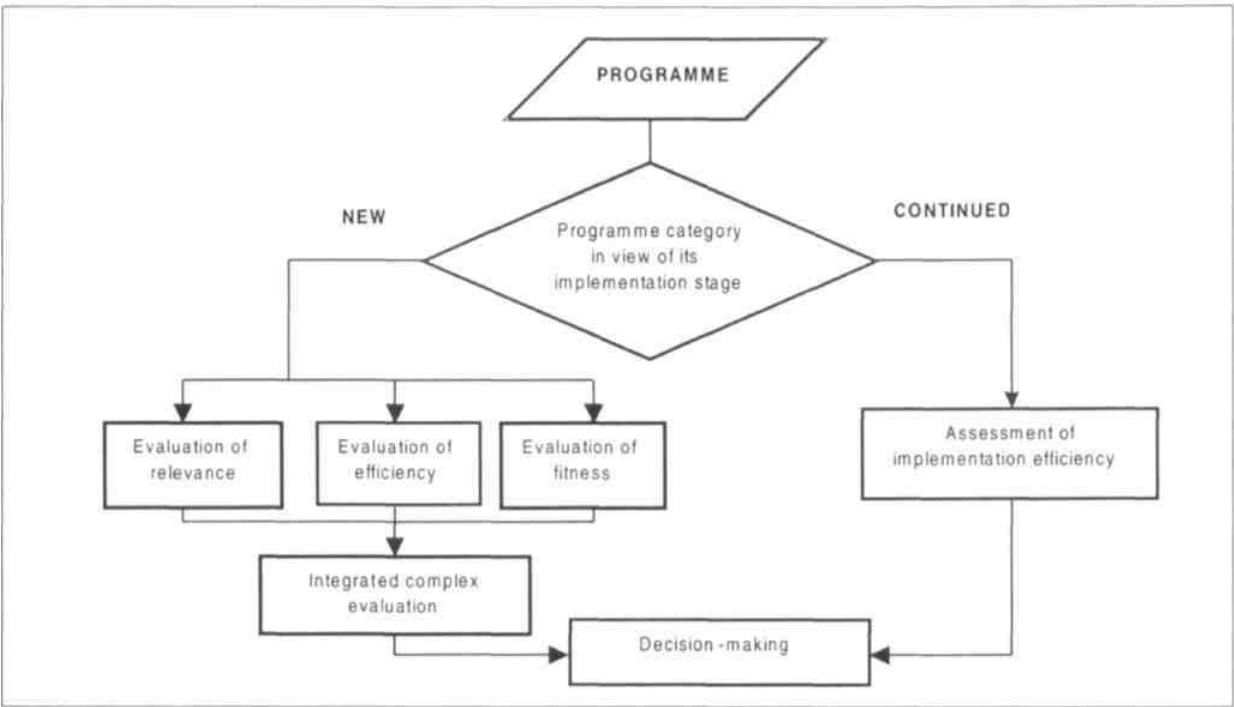
Fig 1. Scheme of budget programme